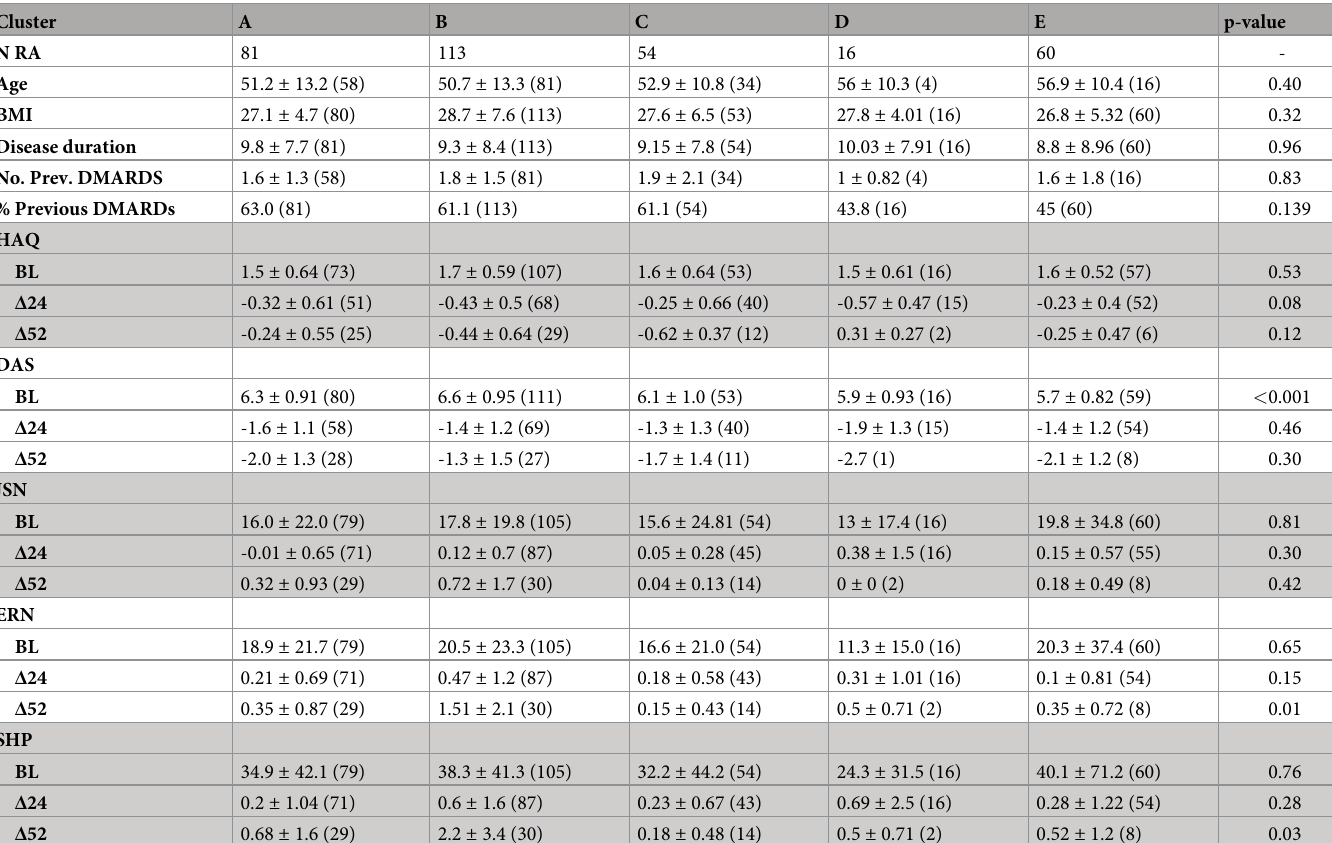
Table 3. Mean and standard deviation of clinical variables for placebo patients in each cluster identified, where p-values have been measured using ANOVA test or Chi